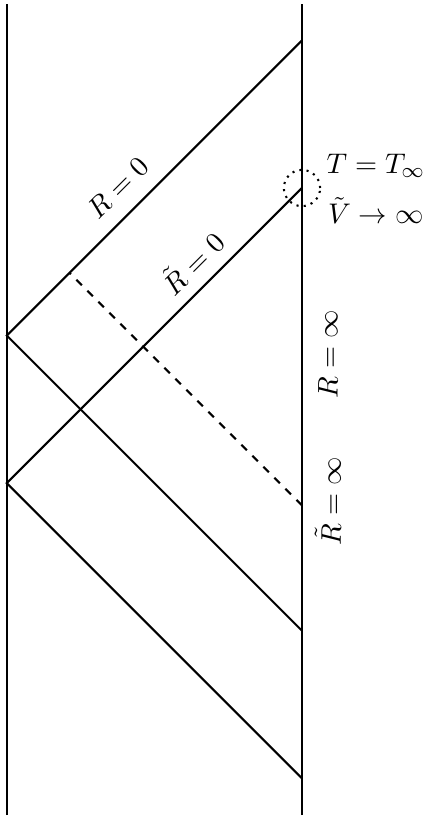
Figure 1 . Penrose diagram displaying the isometry (2.10). The coordinates f T; R g cover the upper Poincar(cid:19)e patch with metric (2.4), while the coordinates f ~ T; ~ R g cover the lower Poincar(cid:19)e patch. The dashed null line represents a possible initial data surface, and the dotted circle highlights the neighborhood of ~ V ! 1 on which we are focusing. This point is the future endpoint of the future horizon and of the boundary of the patch f ~ T; ~ R g